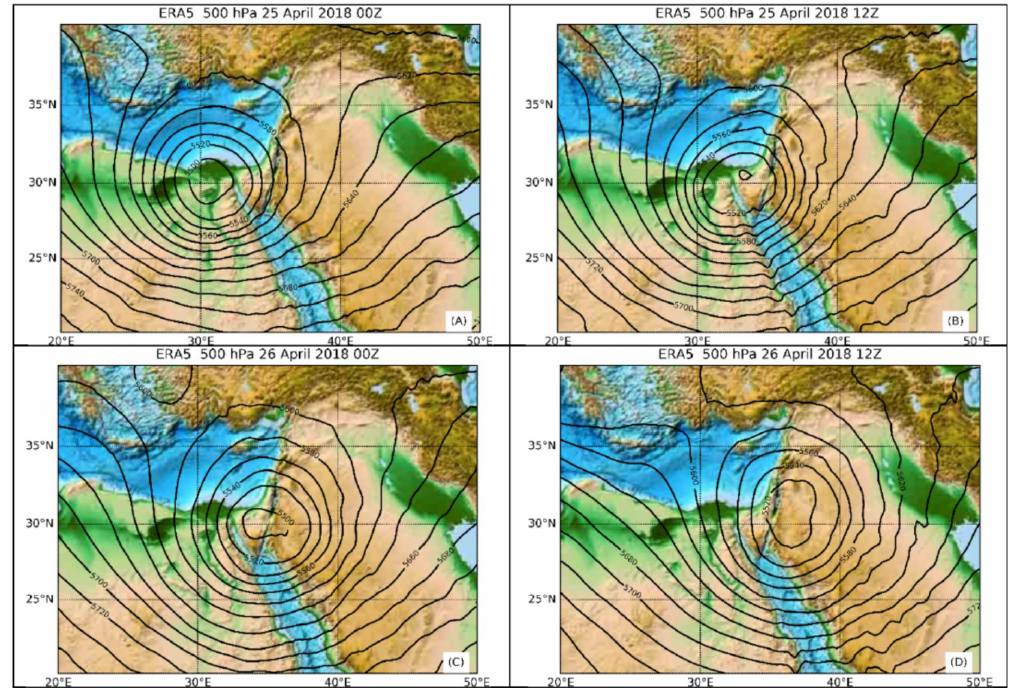
Figure 2. ERA5 reanalysis of a 500 hPa cut-off low-pressure system within the Levant region at 00:00 and 12:00 UTC on 25 and 26 April 2018. ( A ) at 0000 UTC 25 April, ( B ) at 1200 UTC April 25, ( C ) at 0000 UTC 26 April, and ( D ) at 1200 UTC 26 April